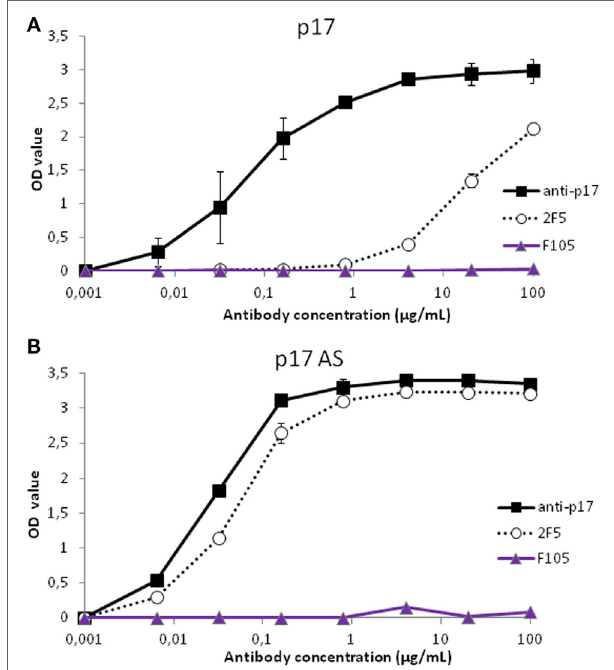
FigUre 2 | bnAb 2F5 cross-reacts with p17 in vitro . (a,B) Reactivity of p17WT (a) or p17AS mutant (B) against anti-p17 (black squares, plain lines) and anti-gp41 2F5 (white circles, dotted line) antibodies. Irrelevant antibody binding (F105 antibody) is displayed with purple triangles and lines. Values represent the mean value of four different experiments in duplicate, and error bars represent the SD of the same